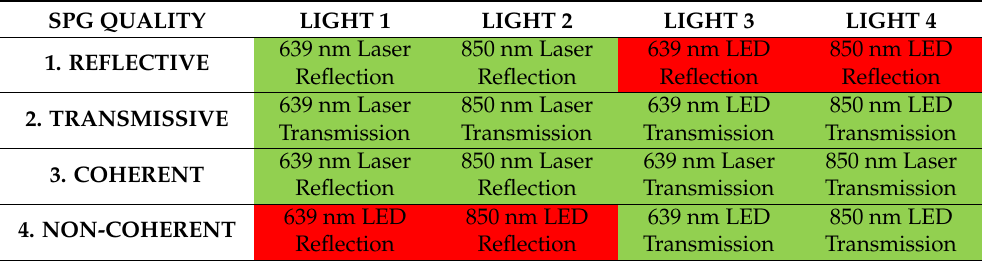
Table 3. Summary of signal quality findings on SPG. Green represents a high frequency density of the PPG primary peak and harmonics compared with the system noise (SQI average > 0.85). Red represents a low frequency density of the PPG primary peak and harmonics compared with the system noise (SQI average < 0.85). LIGHT 1 LIGHT 2 LIGHT 3